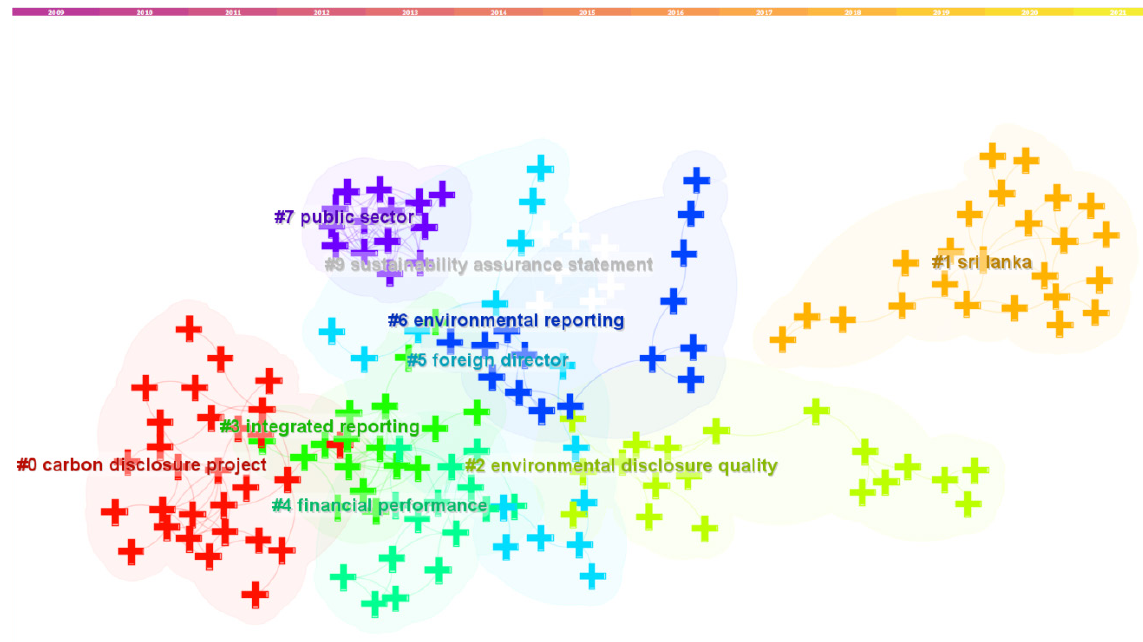
Figure 7. Keyword clustering